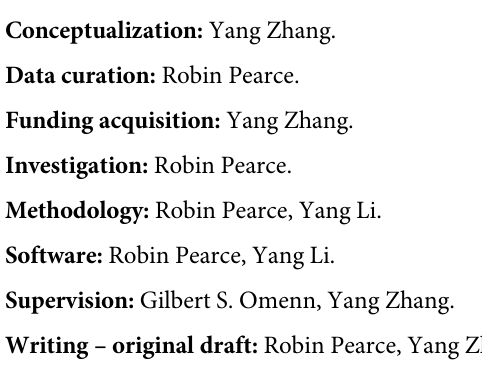
S5 Fig. Case study from two proteins for which DeepFold significantly outperformed AlphaFold2. (PDF) S6 Fig. Histogram distribution of the number of times each of the 7 DeepMSA2 MSAs were selected for the 221 Hard benchmark targets. (PDF) S7 Fig. Definition of the inter-residue orientations predicted by DeepPotential. (PDF) S8 Fig. Depiction of the reduced model used to represent protein conformations during the DeepFold folding simulations. (PDF) S1 Text. MSA Neff value calculation. (PDF) S2 Text. Description of the DeepFold energy function.